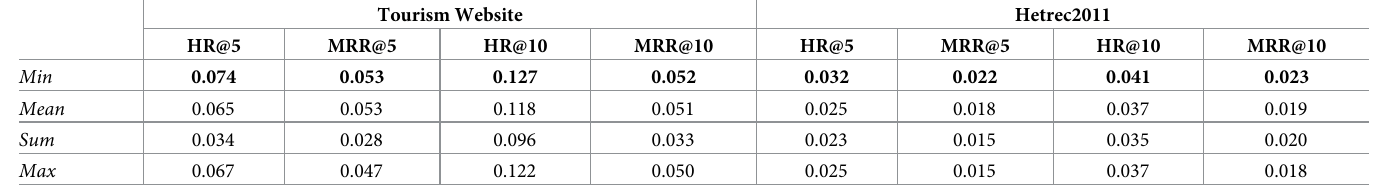
Table 4. HR@k and MRR(k = 5,10) of this model with different aggregation methods on two dataset(Tourism Website and